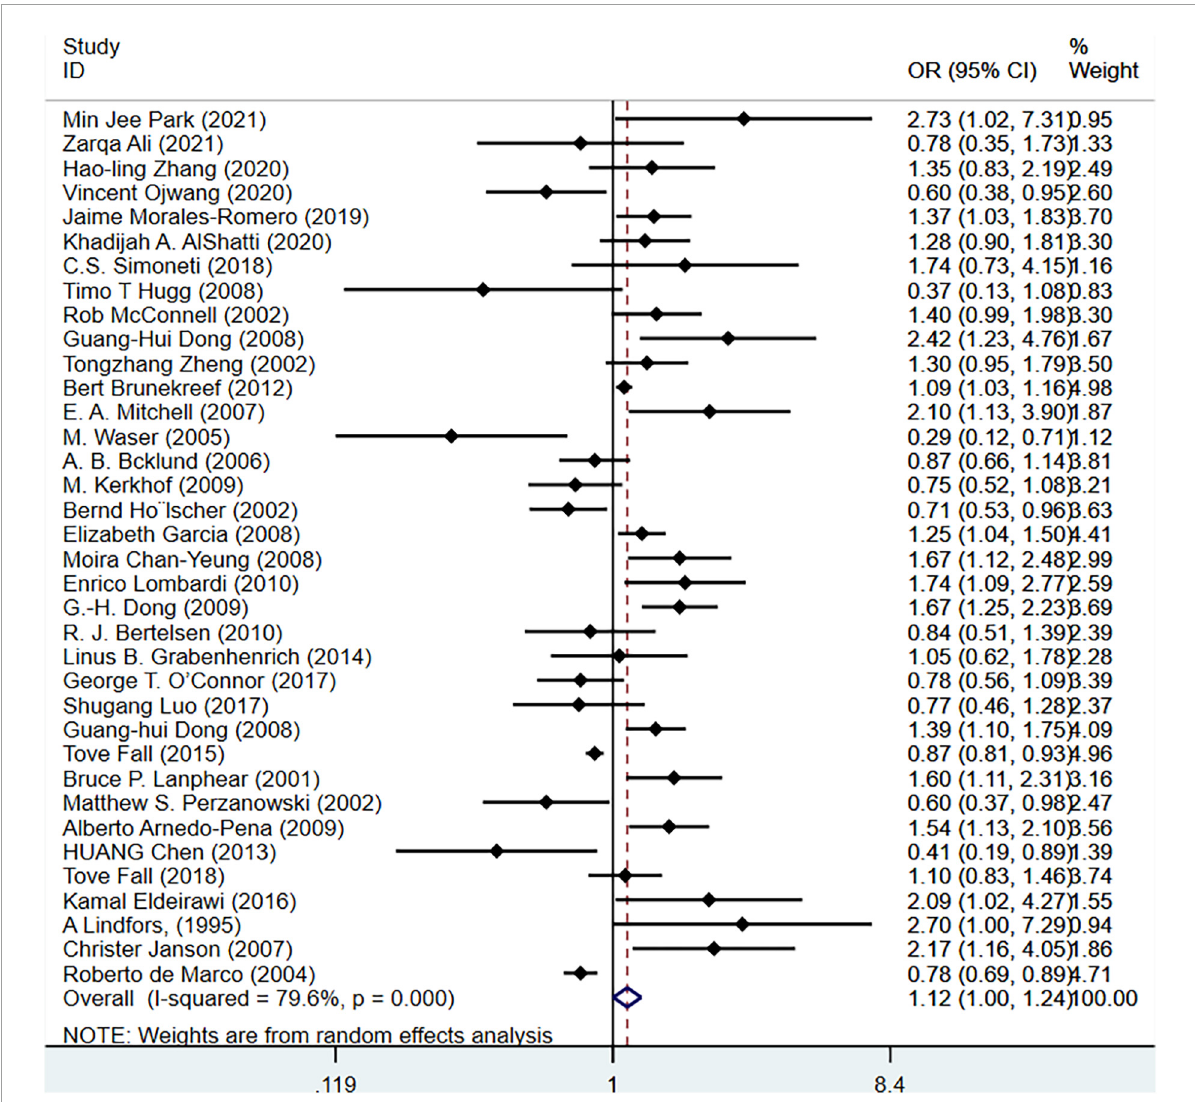
FIGURE4 Forest plot of the association between dog ownership and childhood